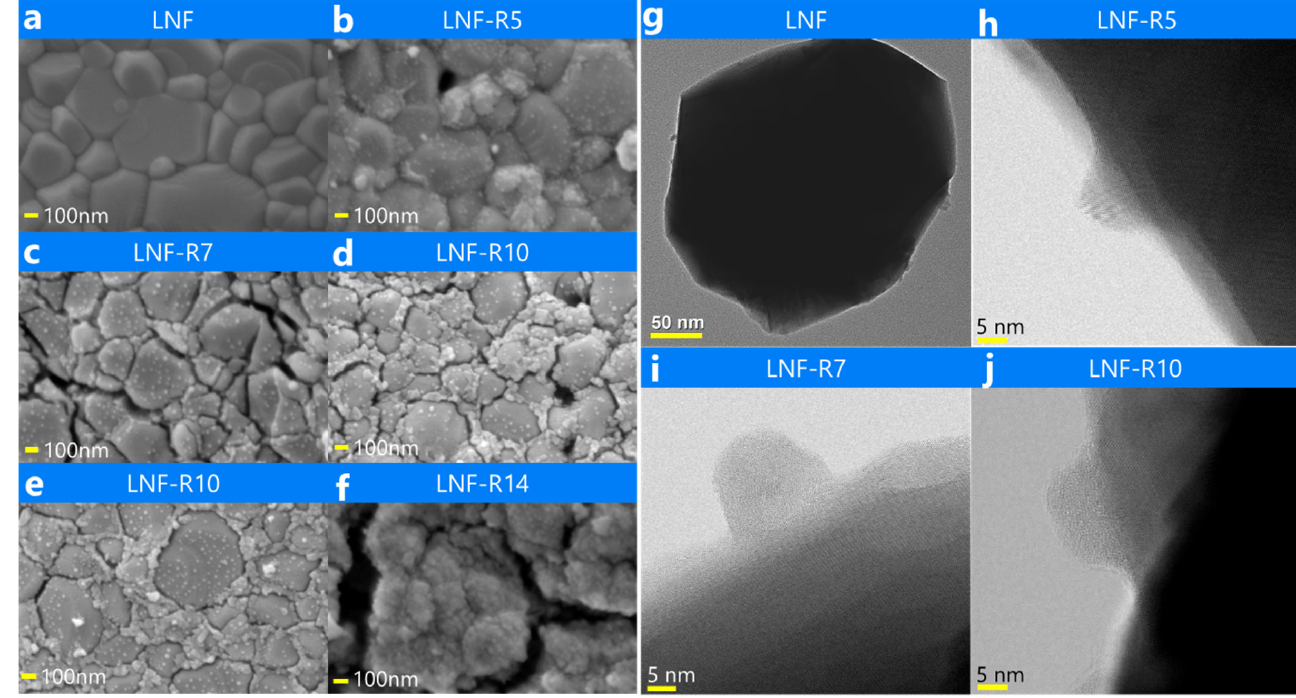
Figure 2. Scanning electron microscopy (SEM) images of LNF samples: ( a ) LNF; ( b ) LNF–R5; ( c ) LNF–R7; ( d , e ) LNF–R10; ( f ) LNF–R14; High-resolution transmission electron microscopy (HR-TEM) images of LNF samples: ( g ) LNF; ( h ) LNF–R5; ( i ) LNF–R7; ( j ) LNF–R10. Table 1. Physical characteristics of the reduction-treated LNF samples.